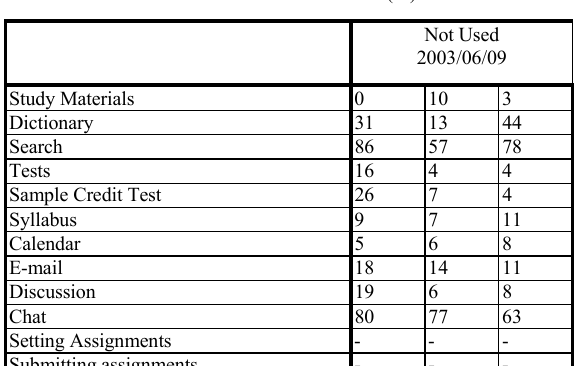
TABLE VII. D ATA ON N OT U SED TOOLS